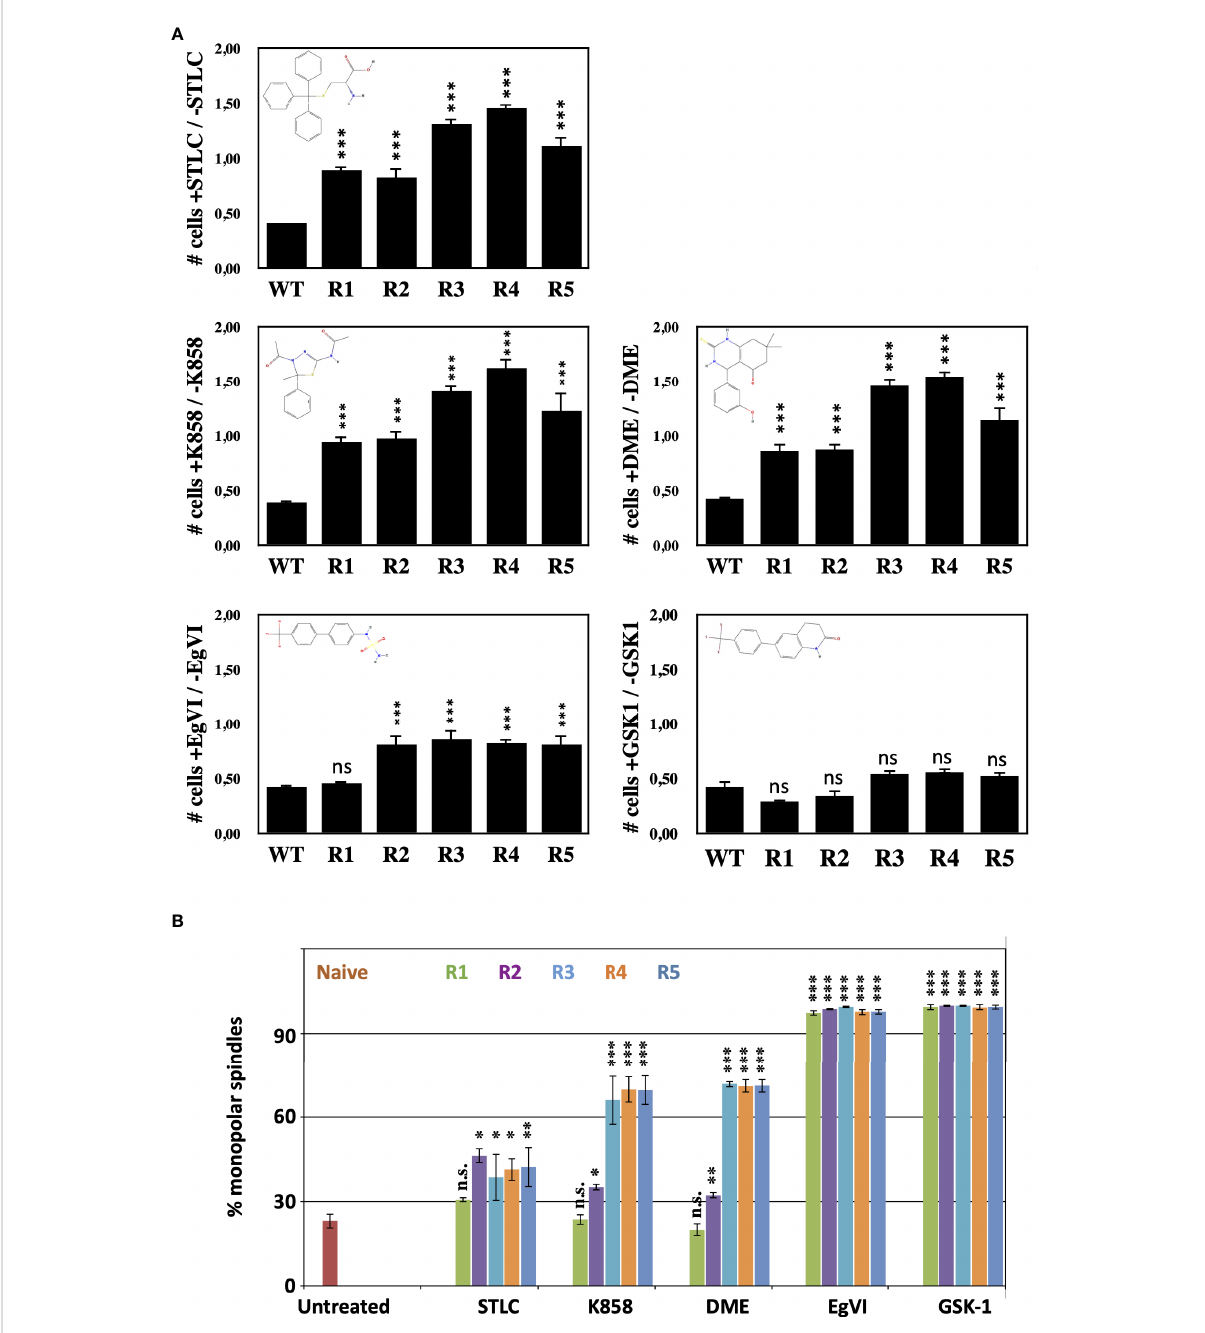
FIGURE 3 STLC resistant clones exhibit variable resitance to other Eg5 inhibitors (A) Proliferations assays with the selected clones in the presence and in the absence of STLC. Ratio of the number of cells in the presence of STLC (10 m M) or K858 (7.5 m M) or DME (5 m M) or EgVI (5 m M) or GSK-1 (0.5 m M) divided by the number of cells in the absence of inhibitor for unselected HCT116 cells and cells from the STLC resistant clones R1, R2, R3, R4 and R5, after 72h. (B) The % of monopolar spindles in the presence of the different Eg5 inhibitors was calculated for each the cell lines from immuno fl uorescence microscopy images of mitotic cells (Supplementary Figure S1). Asterisks indicate signi fi cance values; ns – non- signi fi cant; * p < 0,01, **p < 0,001, *** p <